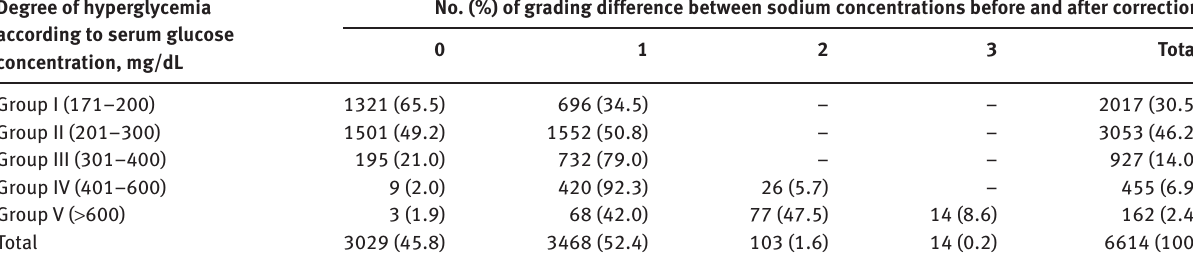
Table 4: Comparison of the pairwise results for degree of hyponatremia between sodium concentrations before and after correction. Degree of hyperglycemia according to serum glucose concentration,